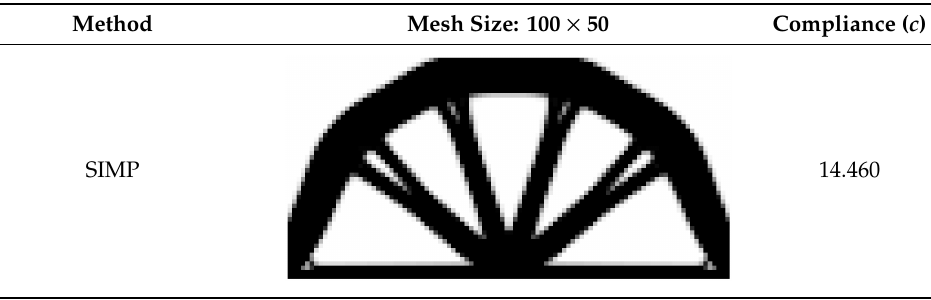
Table 5. Comparison of the best topologies of the pinned-roller plate.